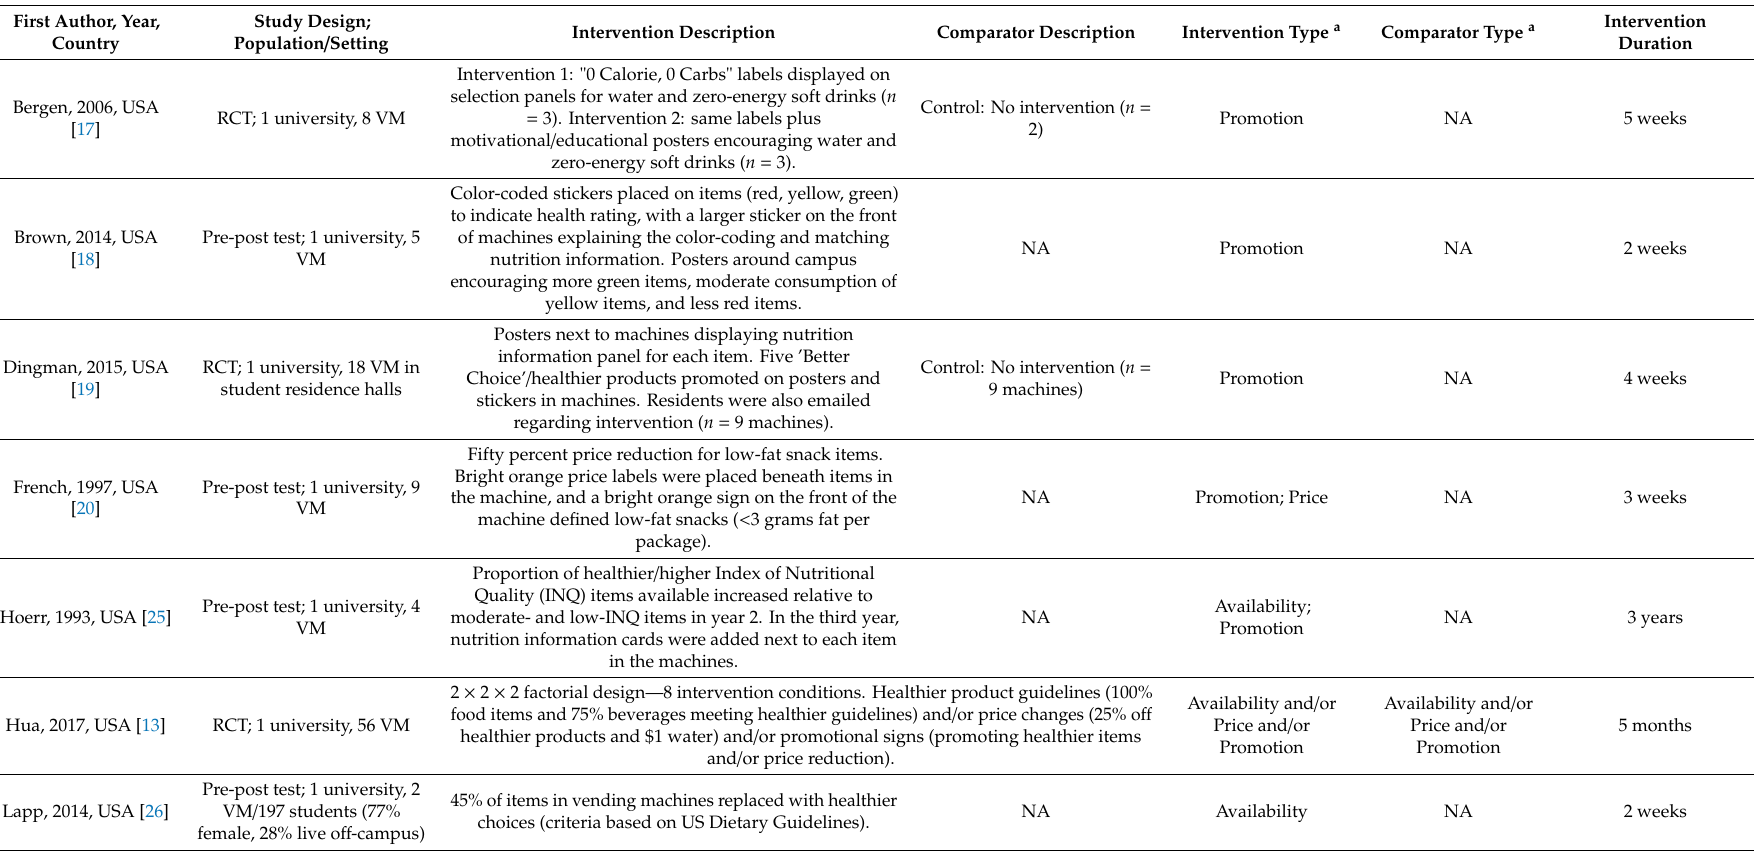
Table 1. Nutrition interventions in vending machines in the university setting: study